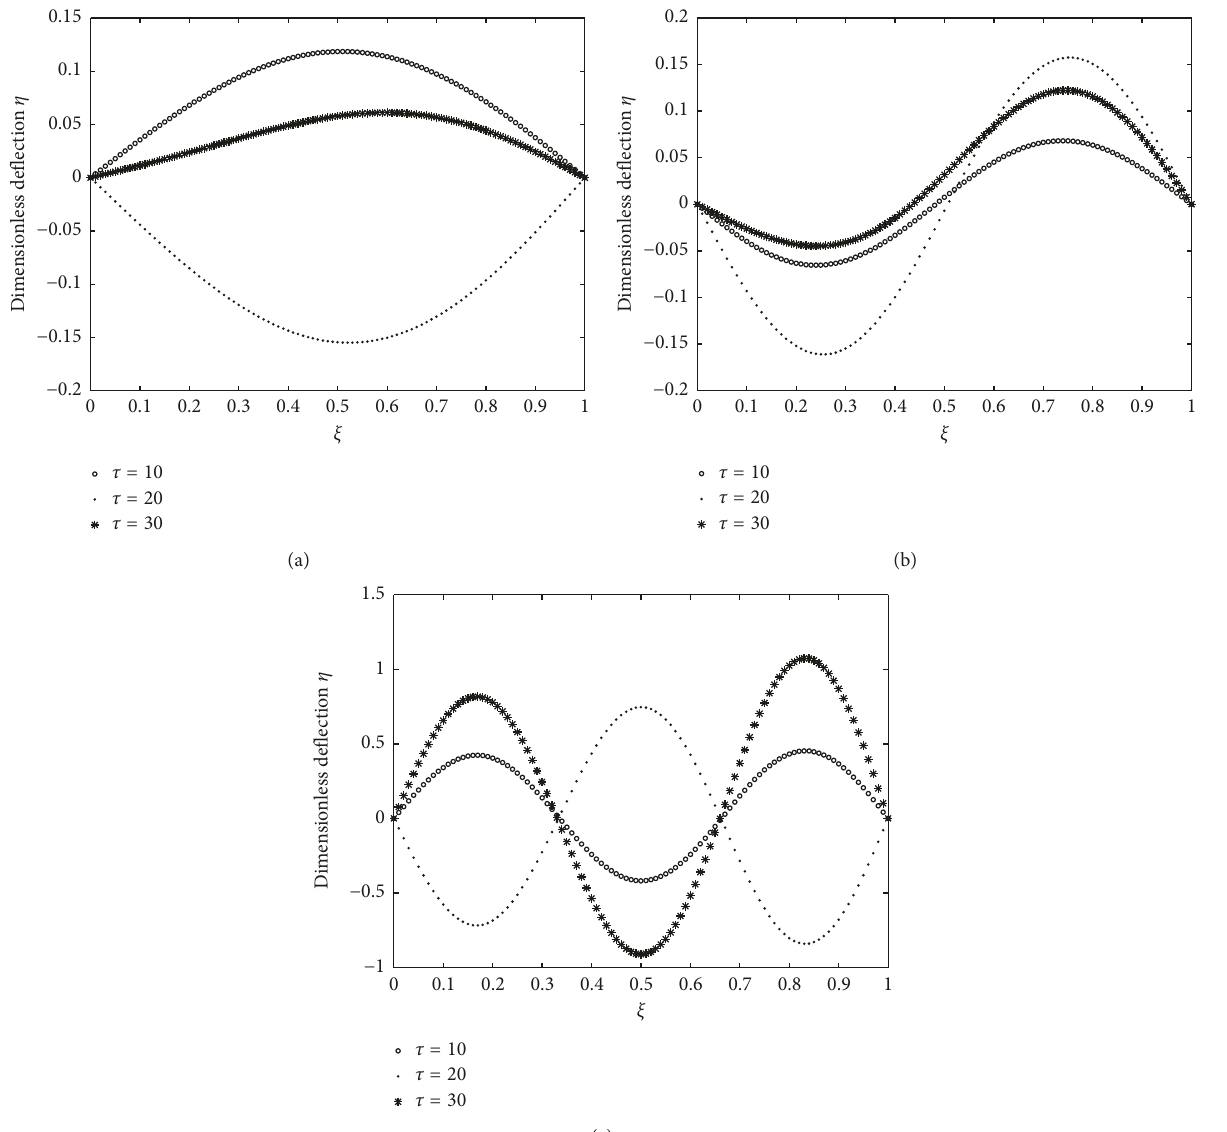
Figure 8: The resonance responses of the pinned-pinned PCF with u � 1 under different supports moving frequencies: (a) ω � 8.44; (b) ω � 38.22; (c) ω �